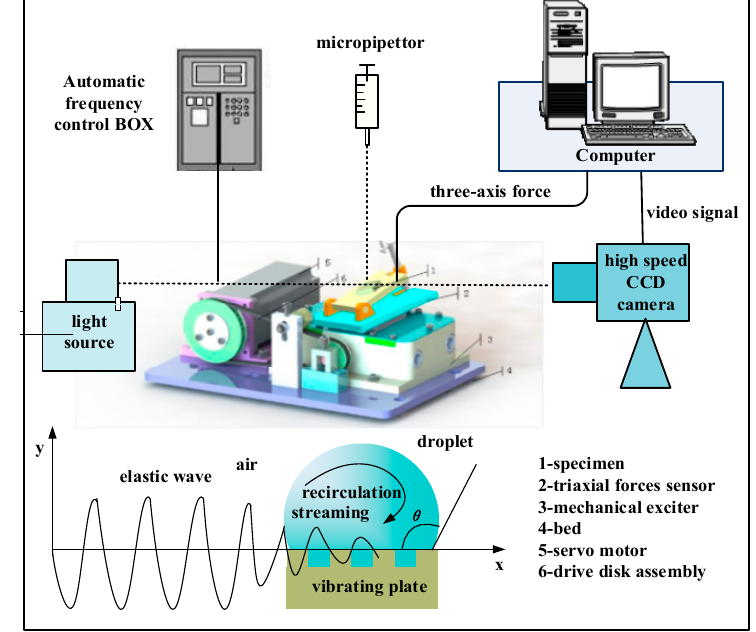
Figure 2. Schematic diagram of experimental apparatus.